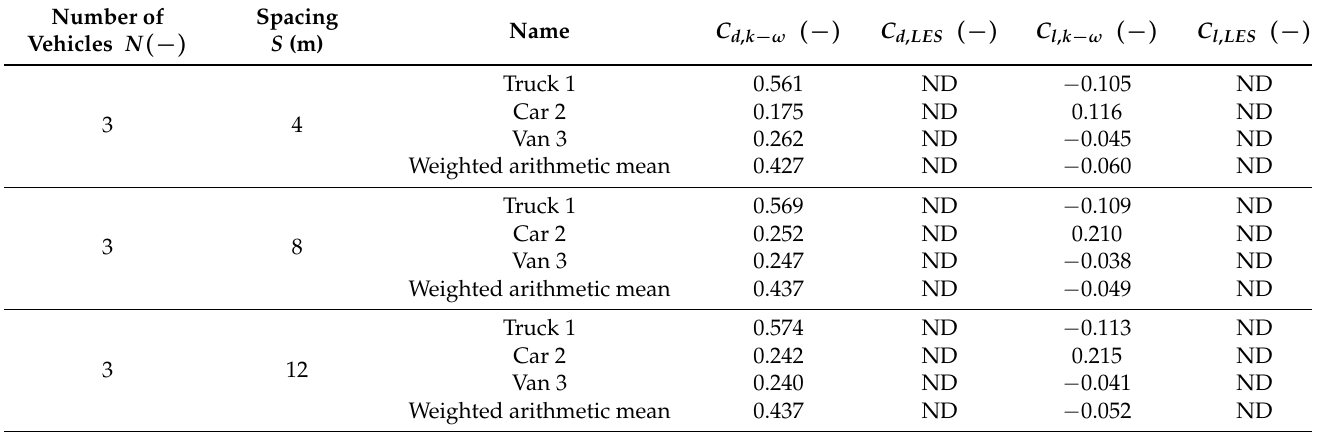
Table A4. Drag coefficient and lift coefficient of vehicles in heterogeneous columns